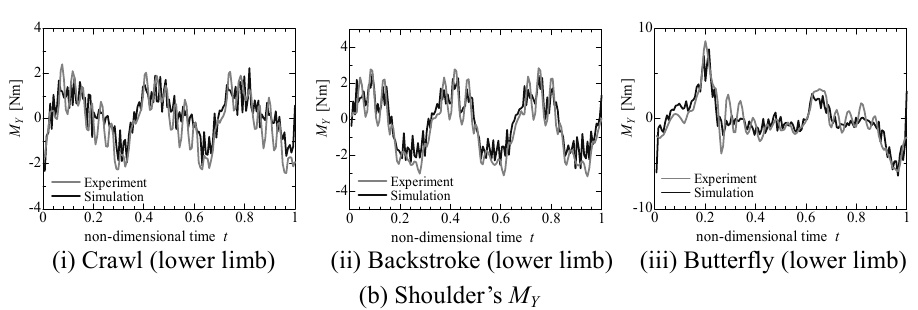
Fig. 12 Comparison of force and moment between experiment and simulation in each swimming